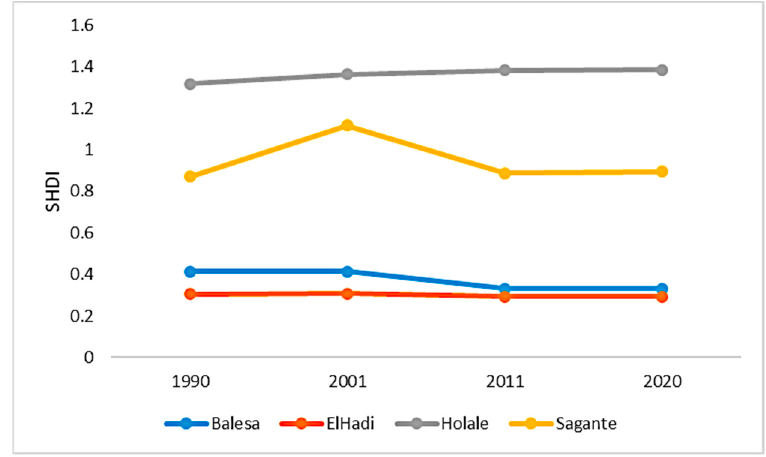
Figure 8. Mean SHDI within a 15 km buffer zone of Marsabit wells clusters in the Northern Kenya/Southern Ethiopia study region. The y -axis indicates the SHDI values while the x -axis indicates the year.